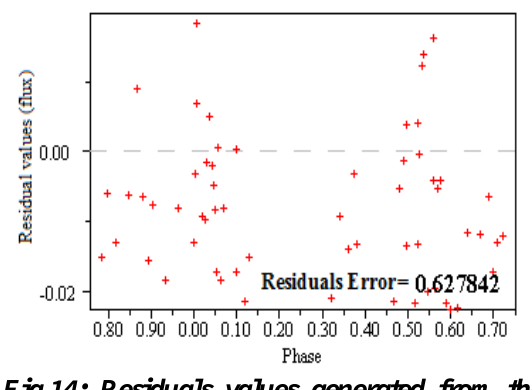
Fig.14: Residuals values generated from the synthetic and experimental data for spotted model of BH Vir using Binary Maker 3, the number in the bottom right hand corner is the sum of squares of the residuals.